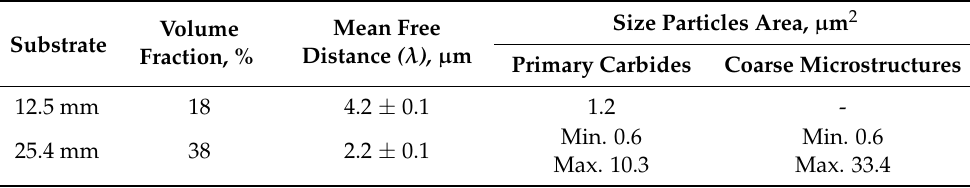
Table 5. Volume fraction, mean free distance, and size particles area.